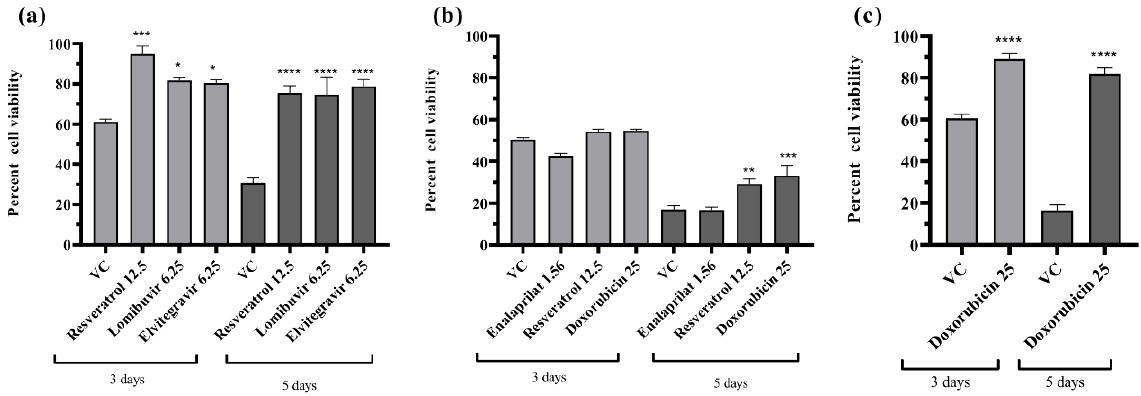
Figure 7. Effect of various drugs on the percent cell viability of the infected cells under different treatment conditions. ( a ) — pre-treatment, ( b ) — post-treatment, and ( c ) — co-treatment. **** p